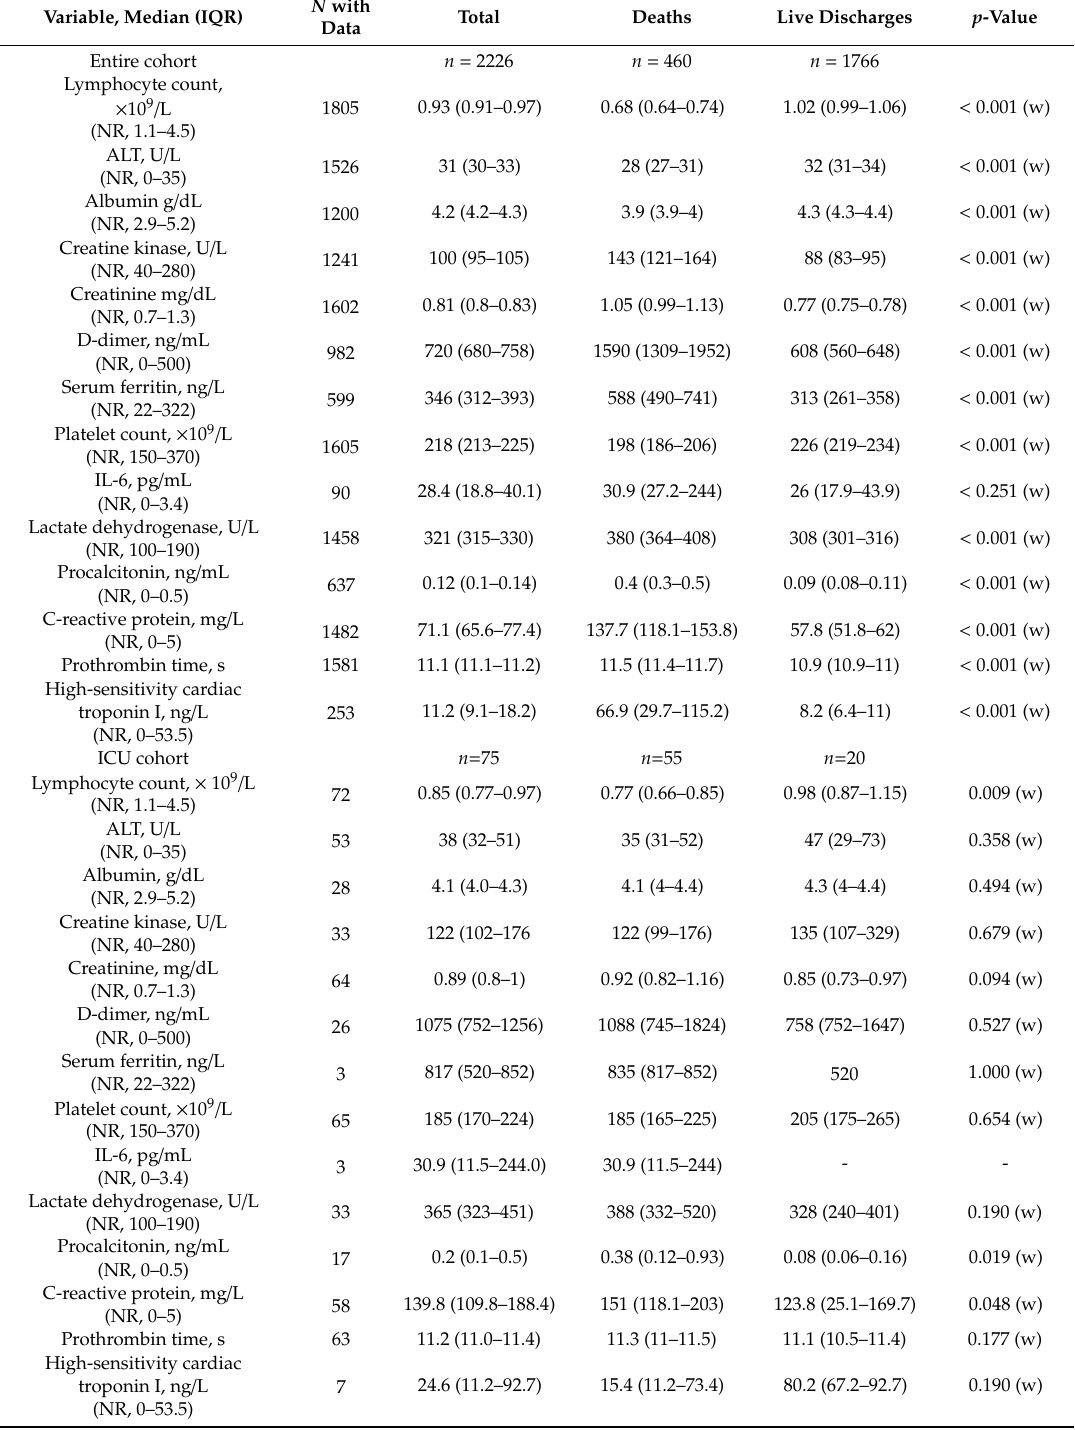
Table 4. Laboratory findings on